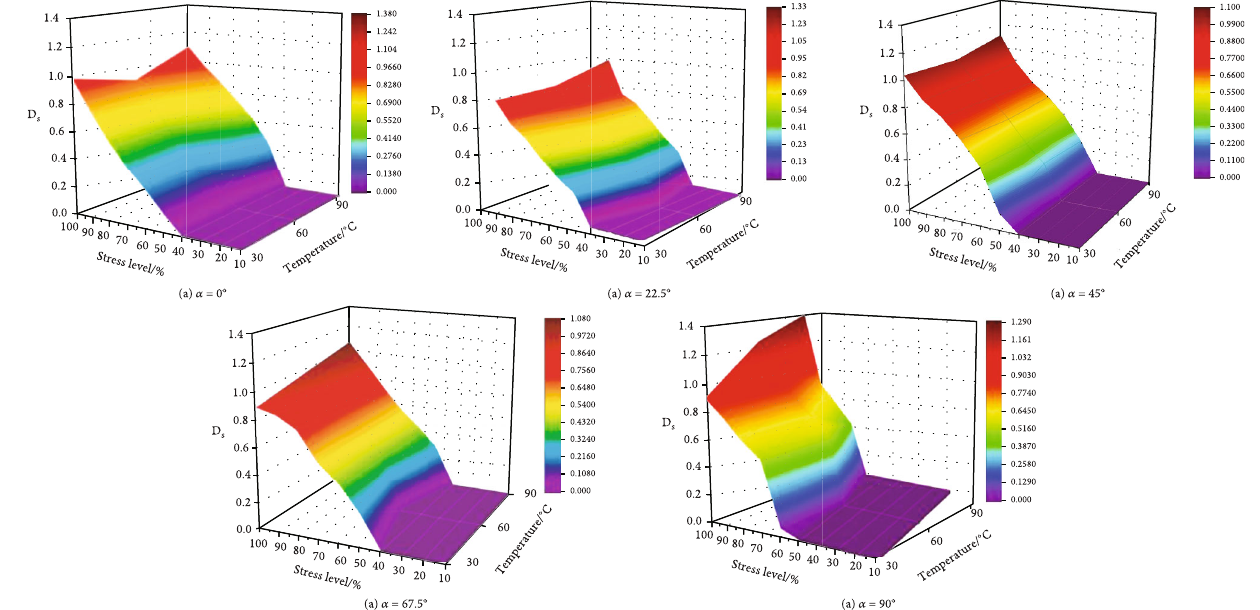
Figure 10: Relationships between di ff erent temperatures, stress levels, and fractal